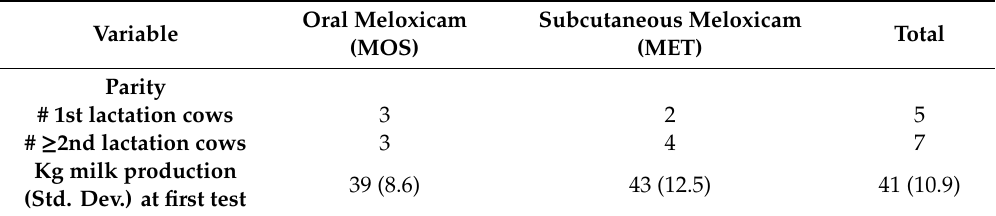
Table 1. Descriptive statistics of study cows.